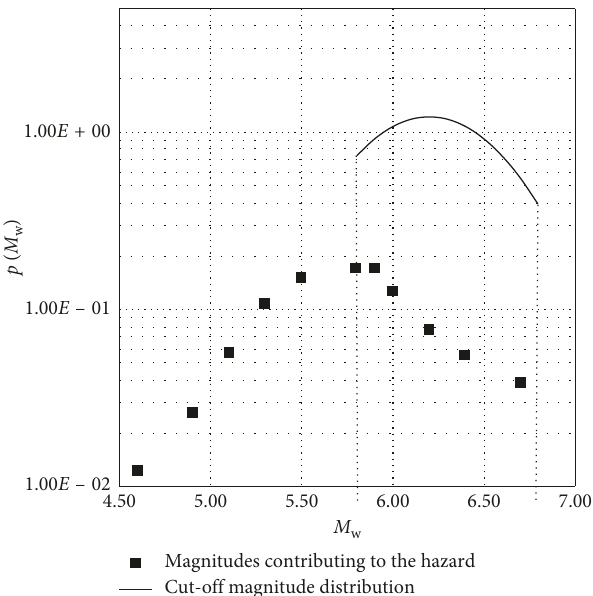
Figure 5: Annual frequency distribution for FS layers between 10 and 20meters, calculated by the method of Kramer and Mayfield [20], with SPT-based correlation of Cetin et al. [21].